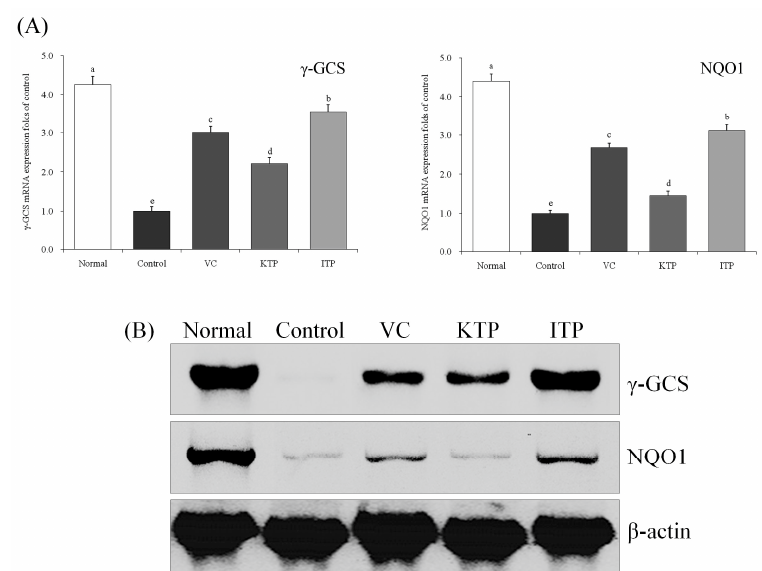
Figure 10. Expression of mRNA ( A ) and protein ( B ) for γ -GCS and NQO1 in liver of mice. a–e Mean values with different letters in the same bar represent significant differences ( p < 0.05) according to Duncan’s multiple-range test. VC: vitamin C (200 mg/kg body weight); KTP: Kuding tea polyphenols (200 mg/kg body weight); ITP: insect tea polyphenols (200 mg/kg body weight).